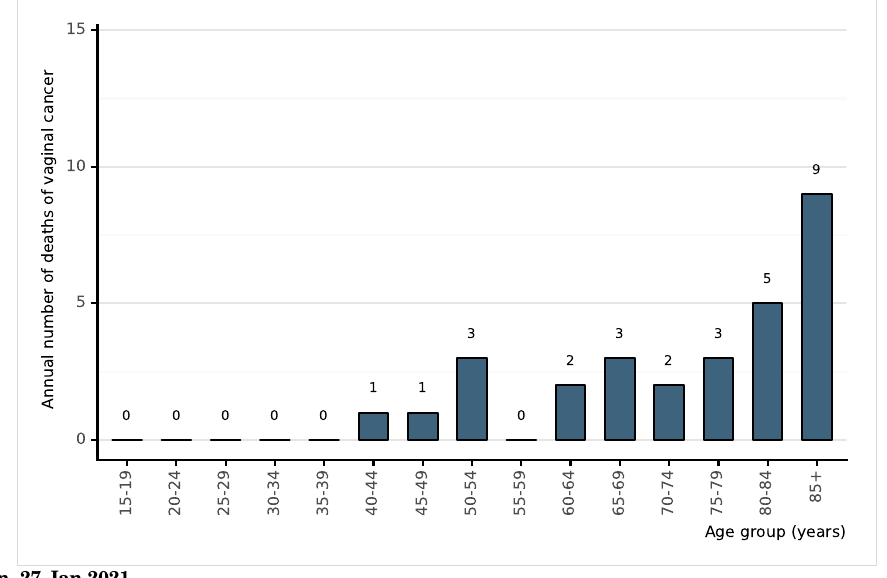
Figure 29: Annual number of deaths of vaginal cancer in Peru (estimates for